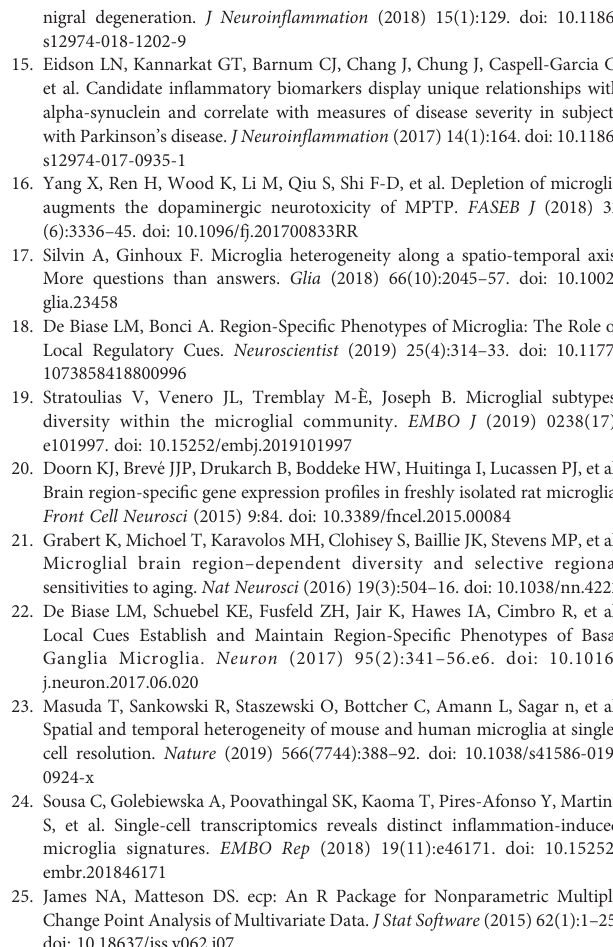
Supplementary Figure 2 | Enrichment of microglial cells across midbrain and striatum. (A) Left panel: UMAP representation of microglial cells from the midbrain (in green) and striatum (in orange); right panel: UMAP representation showing four distinct subsets with few microglial cells (in purple) clustering independently. (B) Heatmap showing the corresponding microglial cells expressing oligodendrocytic markers (padj < 0.05). Supplementary Figure 3 | Immune phenotypes across speci fi c brain regions. (A) Flow cytometry gatingstrategy.(i) Cells of interest were gated basedonforward- scatterarea(FSC-A)andside-scatterarea(SSC-A).(ii)Doubletswereexcludedbased on forward-scatter area (FSC-A) versusforward-scatter height (FSC-H). (iii) Hoechst wasusedtodiscriminatedeadandlivecells.(iv)CD45-FITCandCD11b-PERCP_cy5.5 antibodies were used to gate microglia. (v) CD83-PE antibody was usedto quantify CD83expression. (vi)CD45-FITCandCD11b-PERCP_cy5.5antibodieswereusedto gatethemyeloidcompartment.(vii)CD206-APCantibodywasusedtoquantifyCD206 expression. (B) t -SNEandUMAPplotsshowing Mrc1 expressionacrosscelltypes(left) and microglia (right), respectively. Color barsrepresent z-scores (from low z-score in greytohighz-scoreinred). (C) PercentageofCD206+cellswithintheCD11b+CD45+ population quanti fi ed by fl ow cytometry. Barsrepresent mean ± SEM (cortex in pale green; striatumin orange; midbrain ingreen). Unpaired Student t test(n = 3). (D) Expressionlevelsofmicrogliahomeostaticgenemarkersinmicrogliaisolatedfrom cortex (in palegreen), cerebellum (in pink),striatum(in orange) and midbrain (in green) analyzed byqPCR. Gapdh was used as housekeeping gene. Barsrepresent the mean ± standarderror of the mean (SEM) from three independent experiments. One-way ANOVA followedby a post-hoc Tukey ’ s test was used to infer statistical differences between groups (*p <